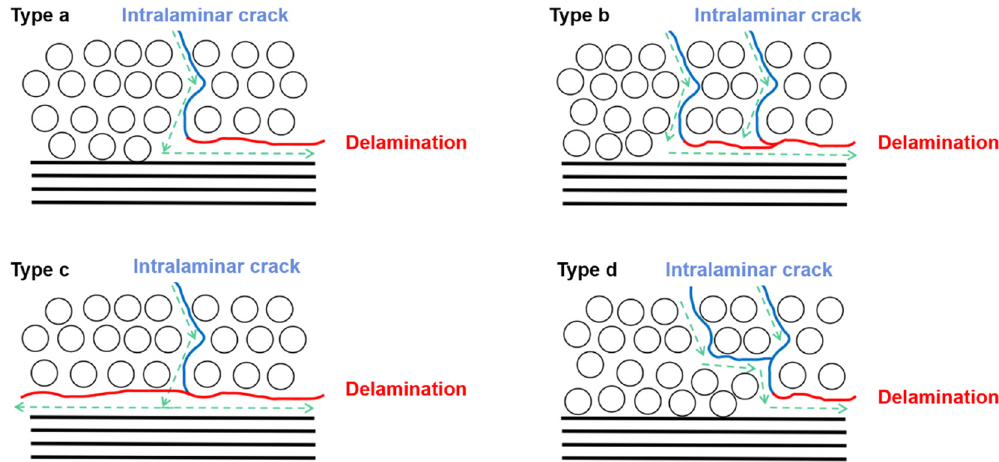
Figure 7: Schematic showing intralaminar crack - induced interlaminar cracking ( blue line: Intralaminar crack; red line: Delamination ) .